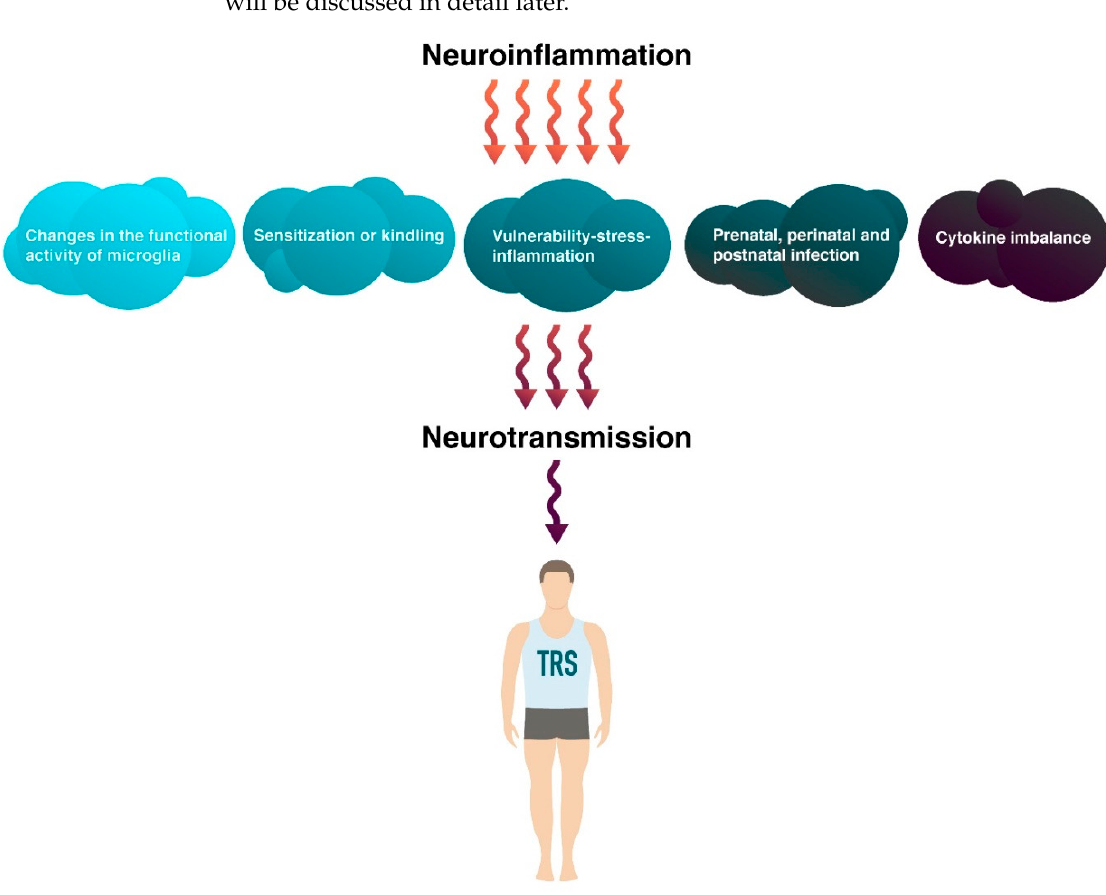
Figure 3. Mechanisms of neuroinflammation that are associated with the treatment-resistant schizophrenia (TRS).